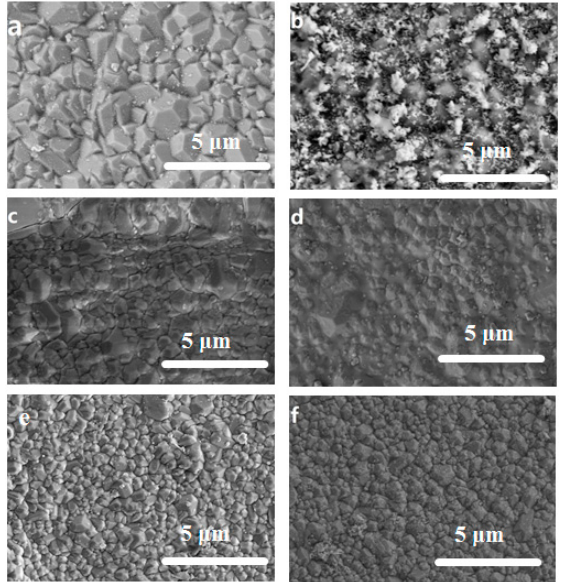
Figure 7. SEM images of NaA zeolite membrane treated by different concentration cations of AgNO 3 ( a ) 0.05 M, ( b ) 0.1 M, NH 4 Cl ( c ) 0.05 M, ( d ) 0.1 M, KCl ( e ) 0.05 M and ( f ) 0.1